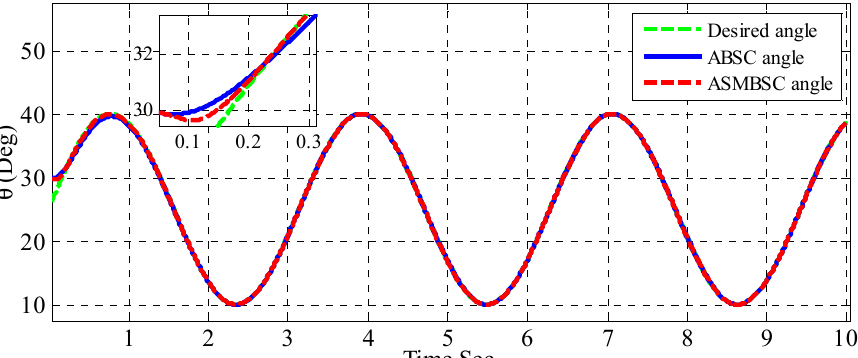
Figure 5. The dynamic response of throttle valve angular position based adaptive backstepping and adaptive sliding mode backstepping controllers.